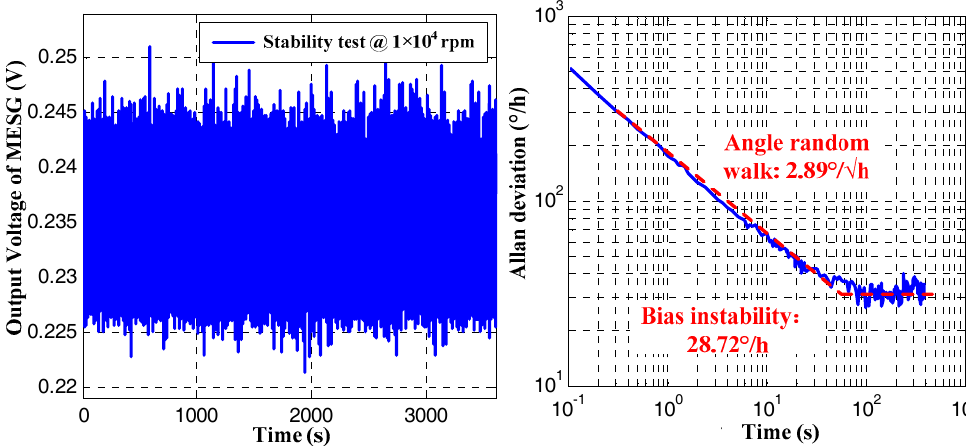
Figure 8. Gyroscope output in time domain and its Allan deviation at spin rate of 1.0 × 10 4 rpm.